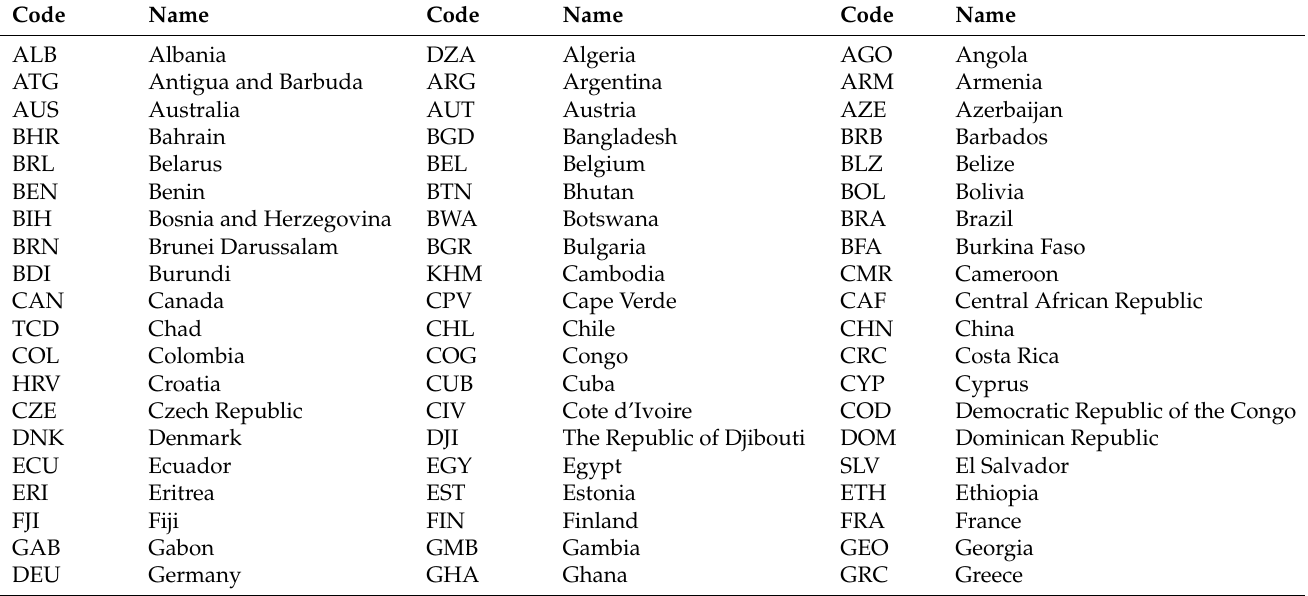
Table A1. List of economies covered in this